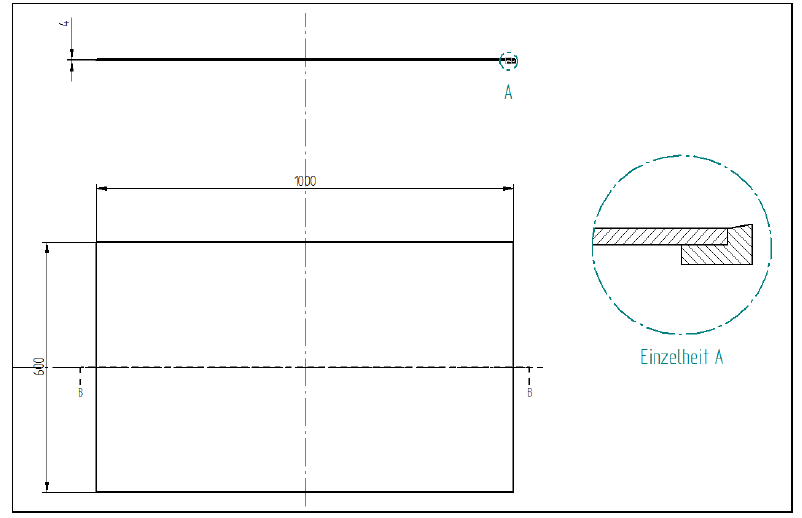
Fig. 3 Sketch of the L-shaped joint of a solar thermal collector.